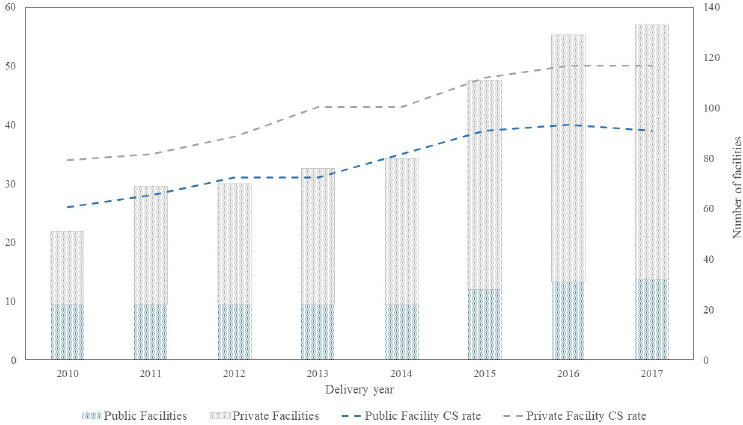
Fig 3. Linear trend in population-based Cesarean section (CS) rate and histogram of number of private and public facilities from 2010 to 2017 by facility type.